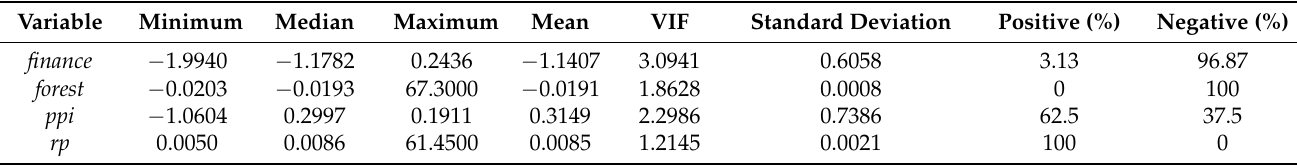
Table 9. Descriptive statistics of GWR model operation